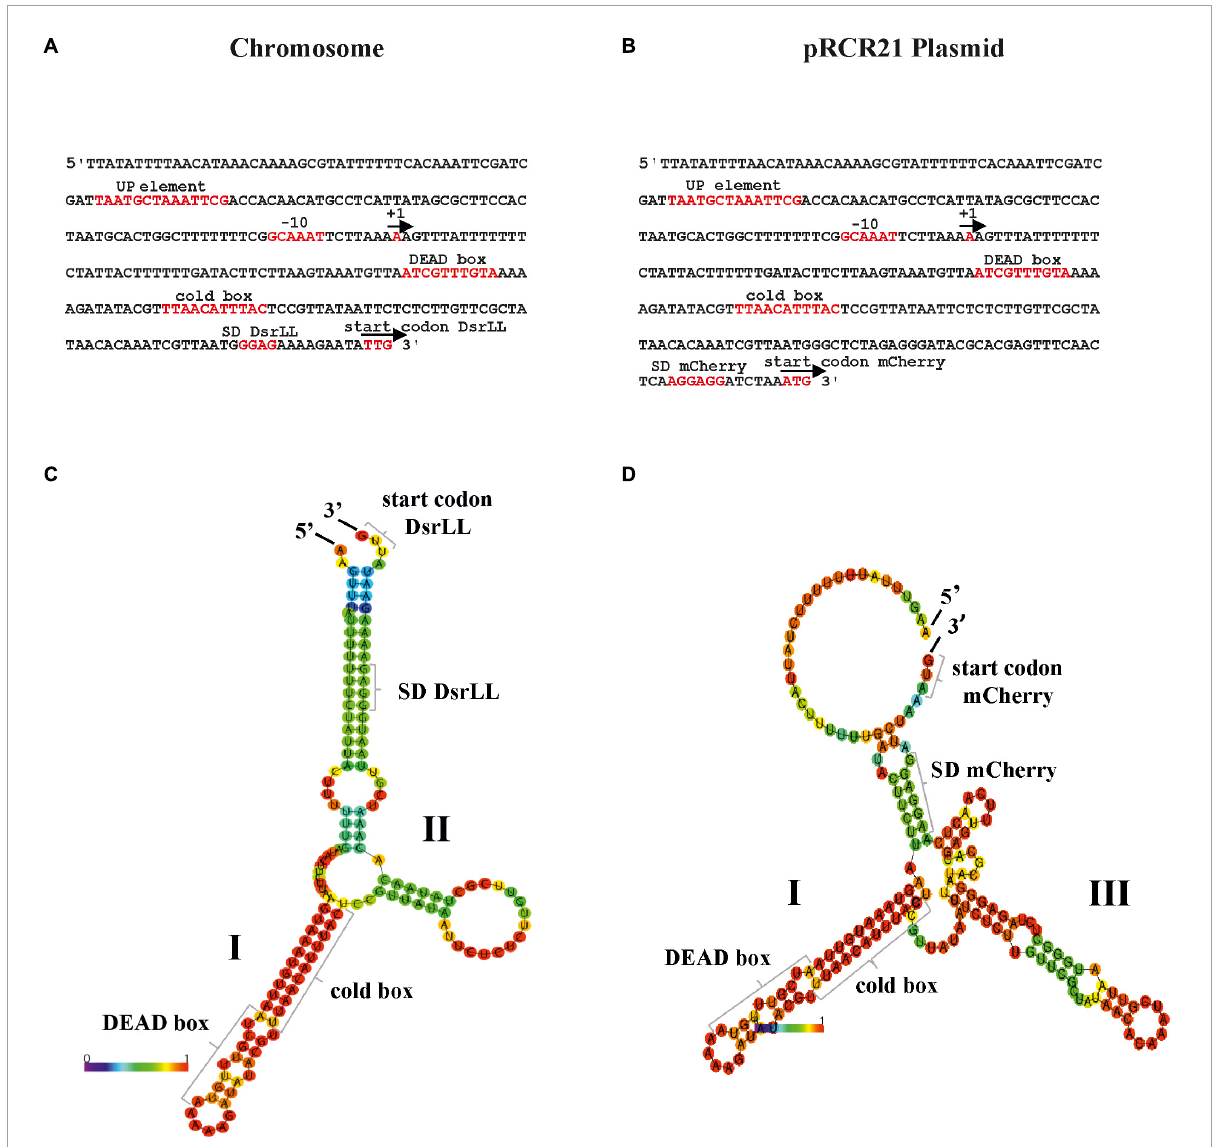
FIGURE4 Regulatory signals for expression from P dsrLL in Lc. lactis AV1n[pRCR21]. The P dsrLL promoters of Lc. lactis AV1n and putative regulatory elements involved in their strength when present in the bacterial chromosome (A) or the pRCR21 plasmid (B) are shown. Also, the predictive folding of the UTR of the dsrLL (C) and mrfp (D) transcripts is depicted. In (A,B) , the + 1 transcription initiation site, − 10 region, UP-element, cold box, DEAD box, as well as the Shine–Dalgarno (SD) sequences and the translation initiation sites of dsrLL (C) and mrfp (D) genes are framed in red. (C,D) Indicate the location and sequence of the 5 (cid:48) - and 3 (cid:48) -ends, secondary structures I and II in (C) and structures I and III in (D) , DEAD box, cold box, ribosomal binding sites, and translation initiation codon (start codon) of the d srLL (C) or mrfp (D) genes. The folding of the UTR from the chromosome and pRCR21 plasmid has a (cid:49) G of − 29.78 and − 39.99 kcal/mol, respectively.